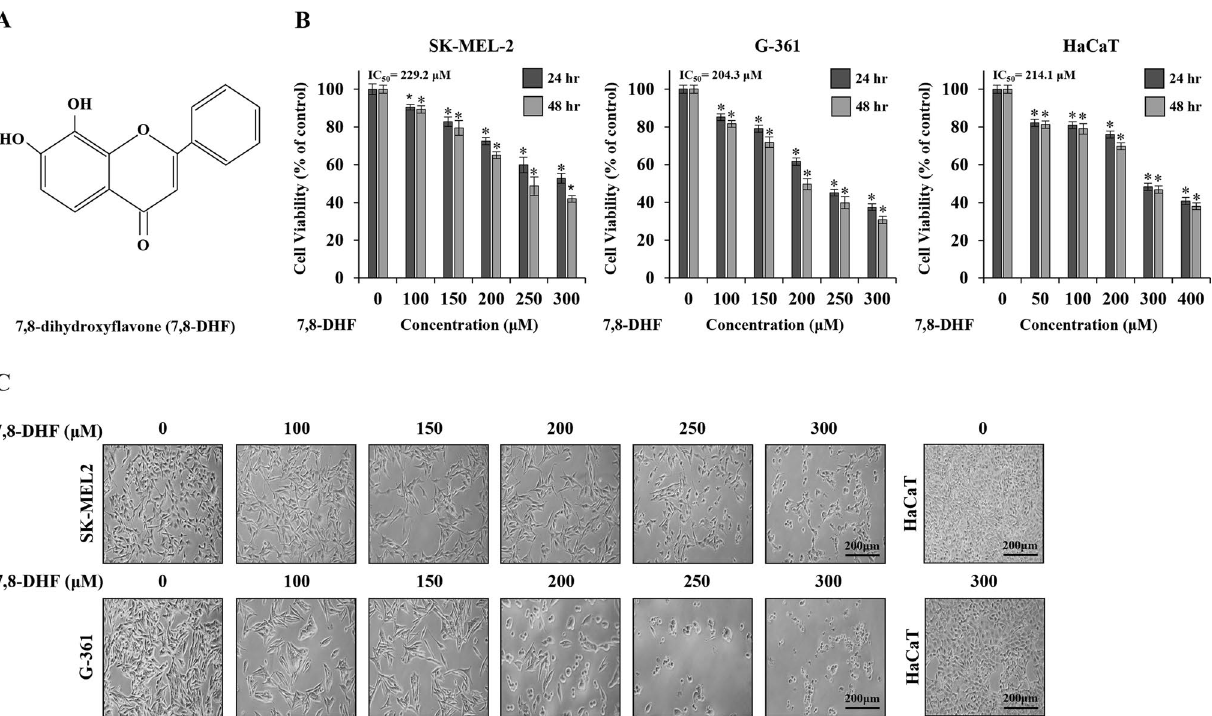
Fig. 1 The effects of 7,8-dihydroxyflavone (7,8-DHF) on viability in malignant melanoma cells and HaCaT cells. A Chemical structure of 7,8- DHF. B The inhibitory effect of 7,8-DHF on the proliferation of melanoma cells. SK-MEL-2 (1.0 × 10 3 cells/well), G-361 (1.0 × 10 3 cells/well), and non-tumoral HaCaT cells (1.0 × 10 3 cells/well) were treated with different concentrations of 7,8-DHF for 24 and 48 h (hr). The viability was measured using an MTS assay kit. C Morphological changes in 7,8-DHF-treated (24 h) SK-MEL-2, G-361, and HaCaT cells and the correspond- ing untreated controls. Data represented the mean ± standard deviation (SD) of three independent experiments. ( * p <